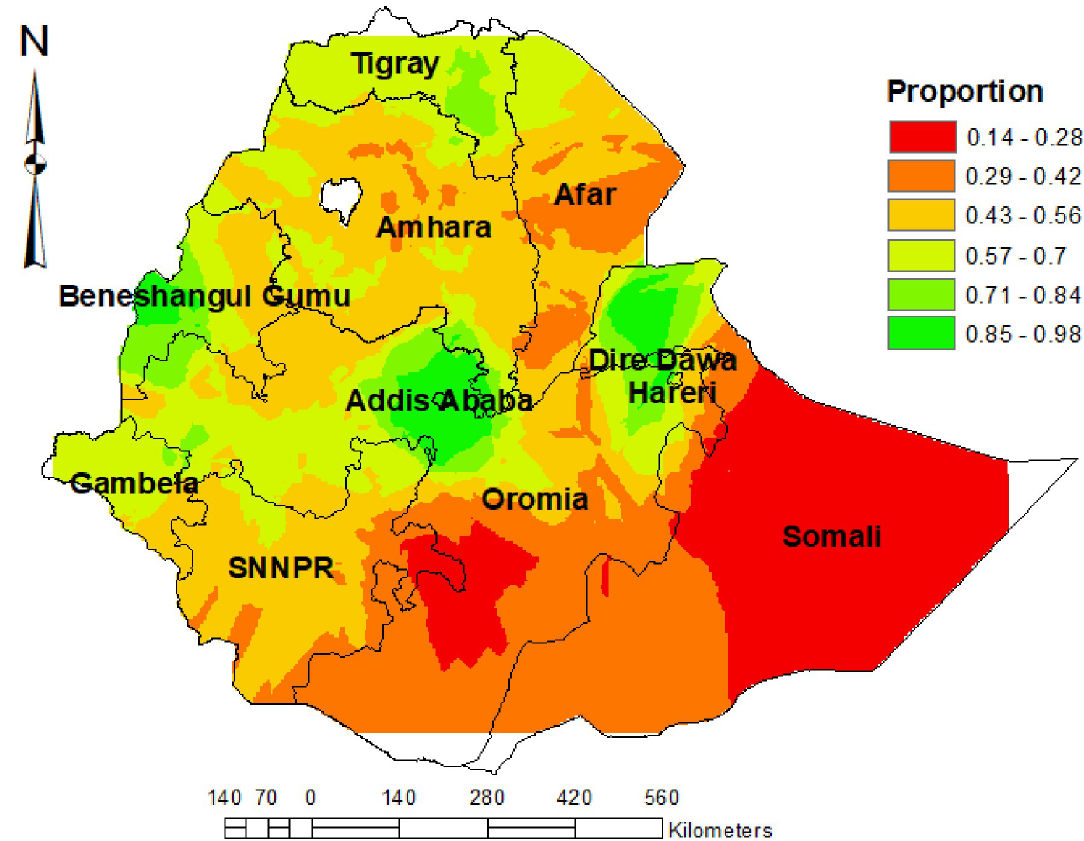
Fig 3. Interpolation of institutional delivery among women who had live birth in the last five years preceding 2019